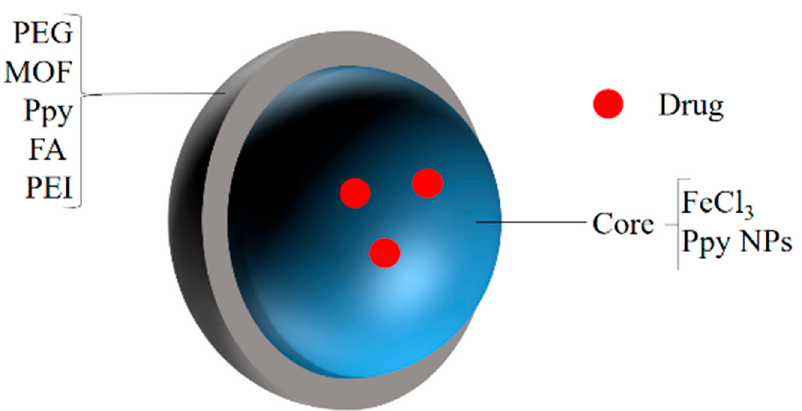
Figure 5 .A generalized structure of polypyrrole ‐ based nanohybrids. Figure 5. A generalized structure of polypyrrole-based